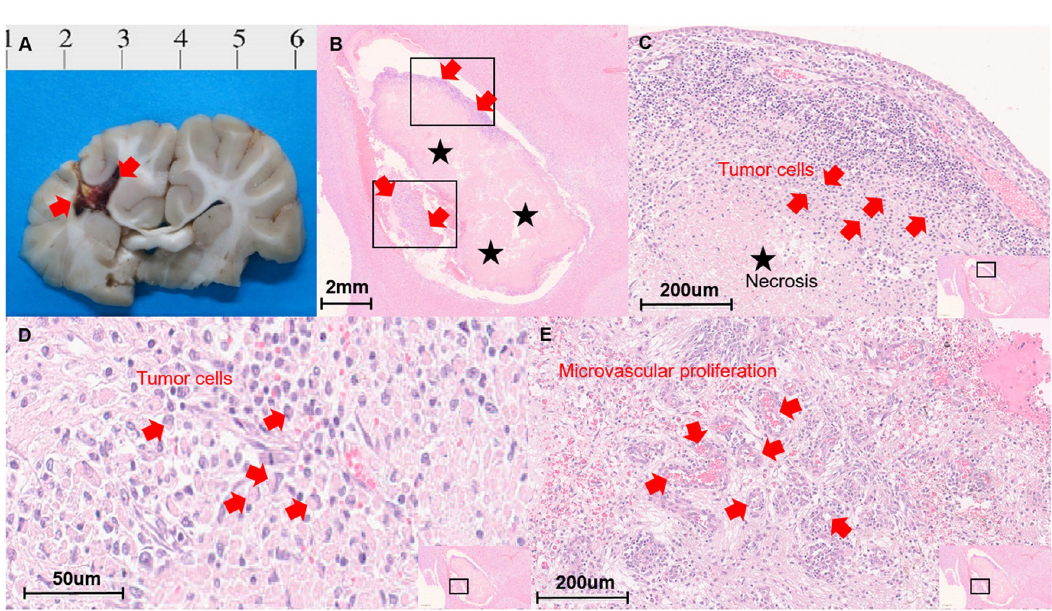
Fig 4. Histopathologic analysis. (A) The gross specimen shows a necrotic mass at the right frontoparietal white matter, the tumour implantation site. (B) There were scattered peripherally located tumour cells (arrows) and central necrosis (stars) on Harris’ haematoxylin solution and eosin Y (H&E)-stained images. (C) Multiple gemistocytic tumour cells are located between the necrotic and inflammatory portions. (D) On high-magnification view, the presence of glioblastoma multiform (GBM) tumour cells (arrow) was confirmed. (E) The characteristic microvascular proliferation in GBM tissue is also demonstrated in